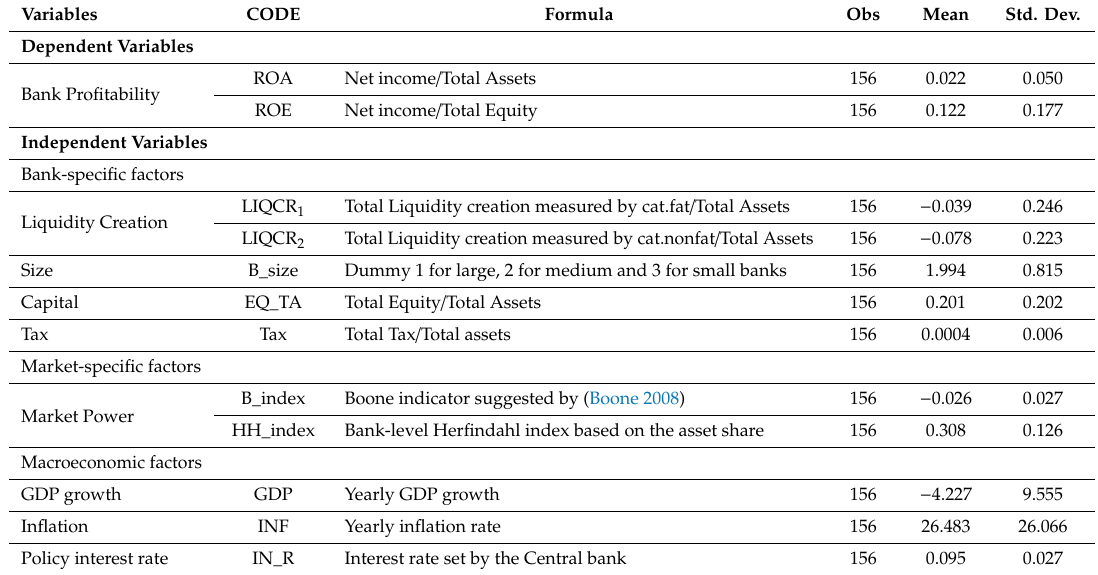
Table 2. Definition of